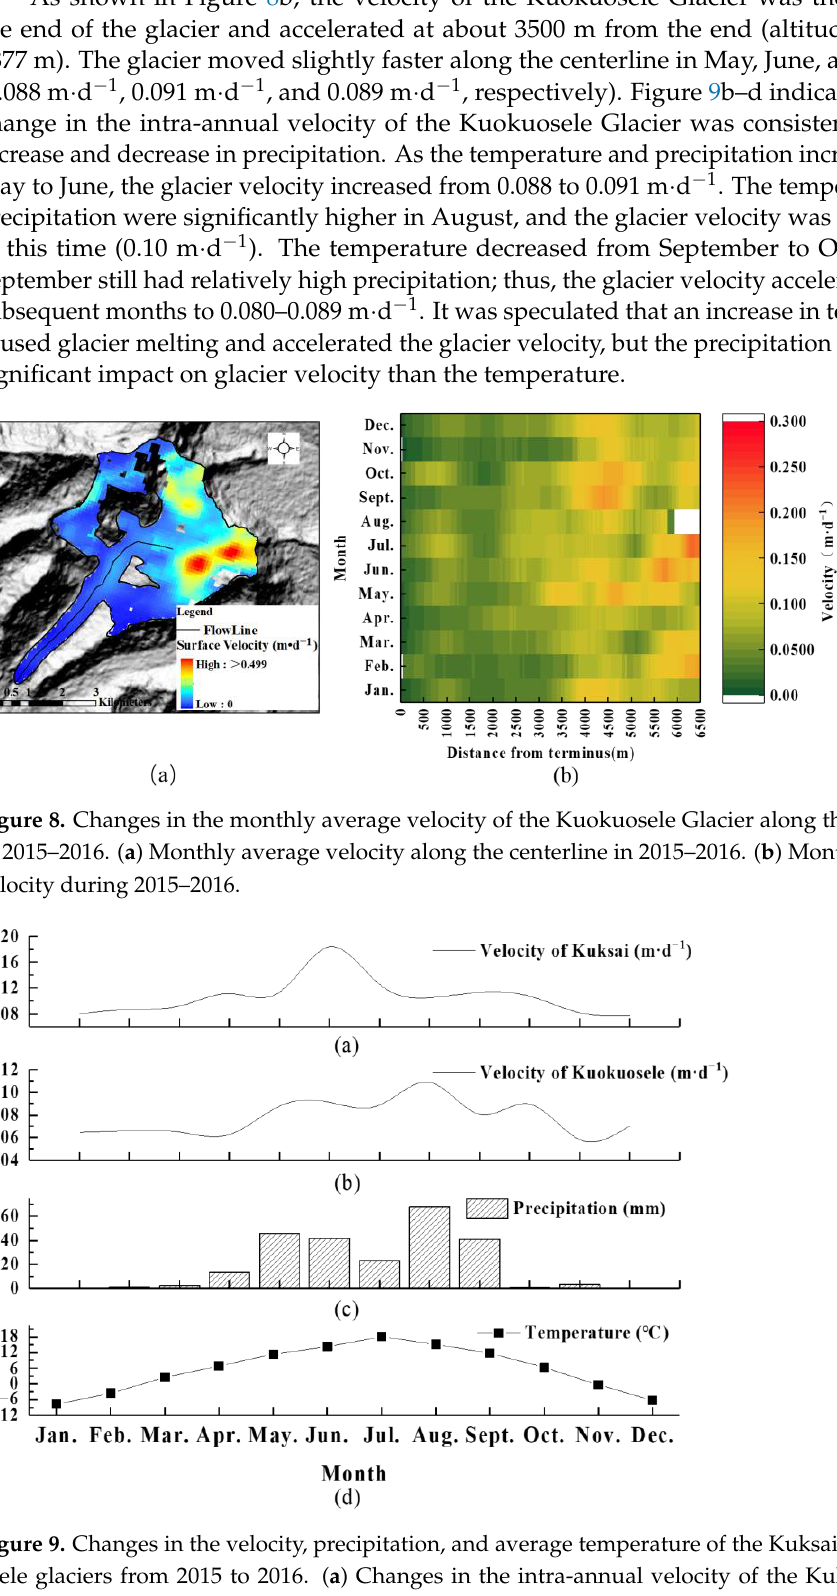
Figure 7. Changes in the monthly average velocity of the Kuksai Glacier along the centerline in 2015 – 2016. ( a ) Monthly average velocity along the centerline in 2015 – 2016. ( b ) Monthly average velocity during 2015 – 2016.